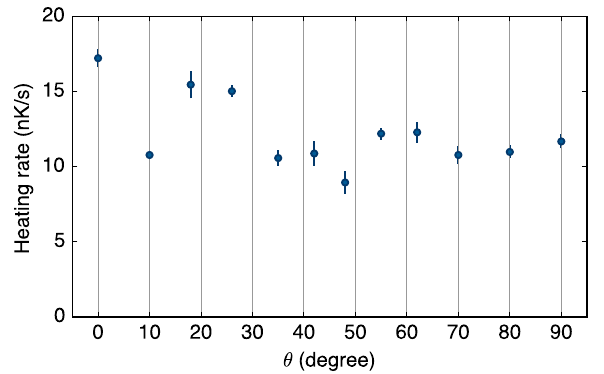
FIG. 9. Measured heating rate of the undiffracted BEC at equilibrium in a V 0 ¼ 18 E 2D lattice at various R